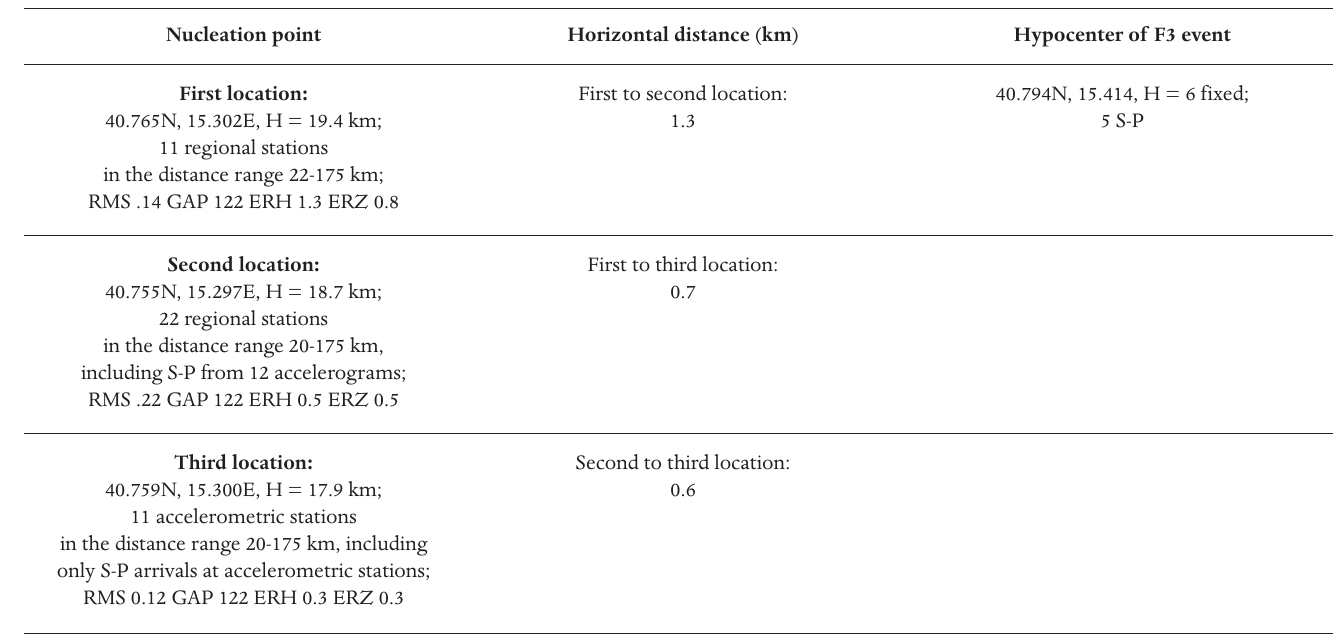
Table 1. Hypocenter locations of the Campania–Lucania 1980